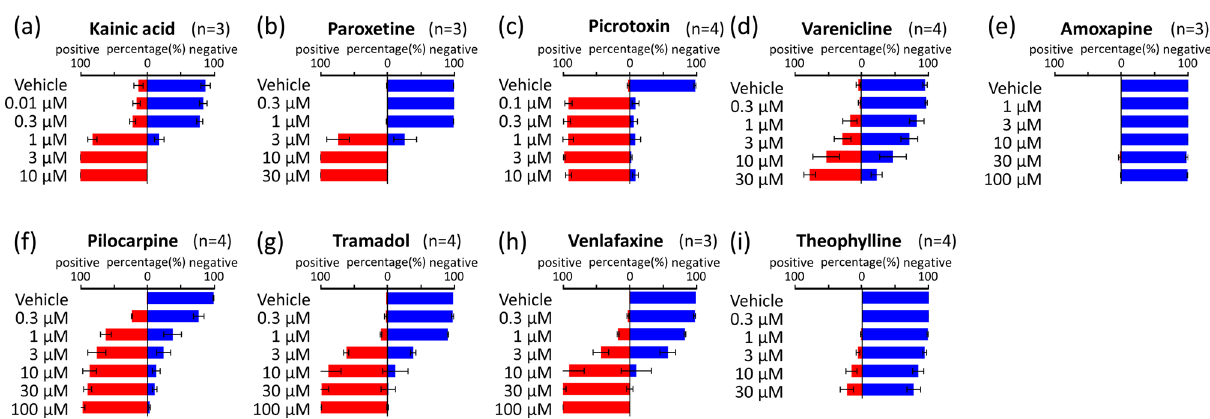
Figure 5. Concentration-dependent prediction of seizure risk in non-training drugs by AI. AI predicted the negative probabilities (blue bar) and seizure risk (red bar) at each concentration. (a) Kainic acid, (b) paroxetine, (c) picrotoxin, (d) varenicline, (e) amoxapine, (f) pilocarpine, (g) tramadol, (h) venlafaxine, (i)